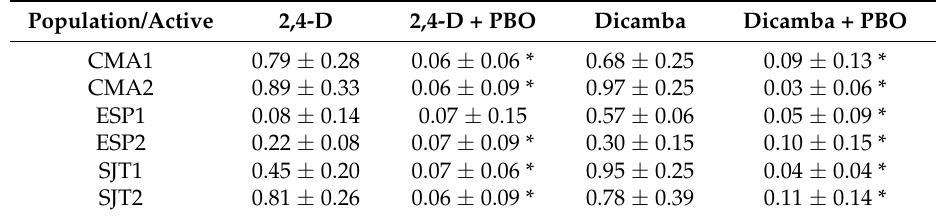
Table 2. Fresh weight of six biotypes of Amaranthus hybridus with treatments of 2,4-D; 2,4-D + piperonil butoxide (PBO); dicamba; and dicamba + PBO.